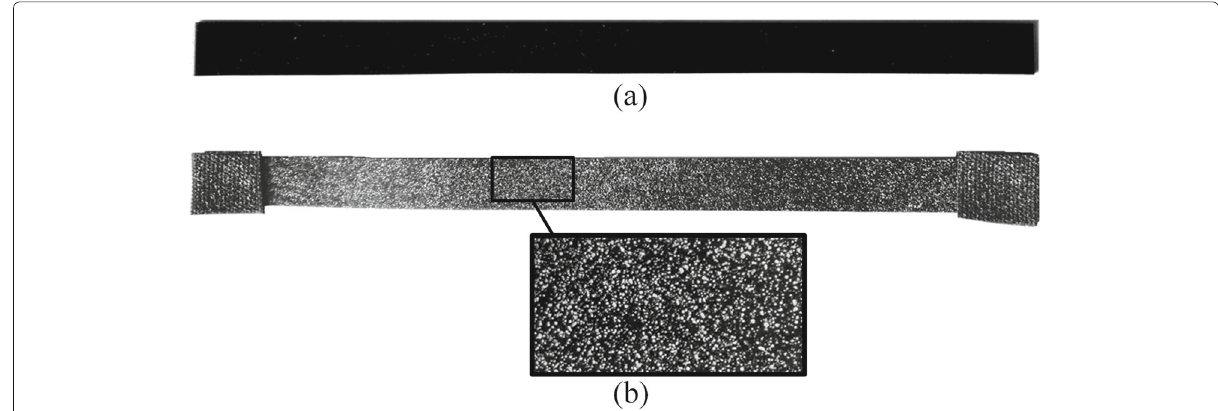
Fig. 4 a Rubber specimen without speckled pattern and b specimen applied with speckled pattern and additional pieces of rubber at the grip contact